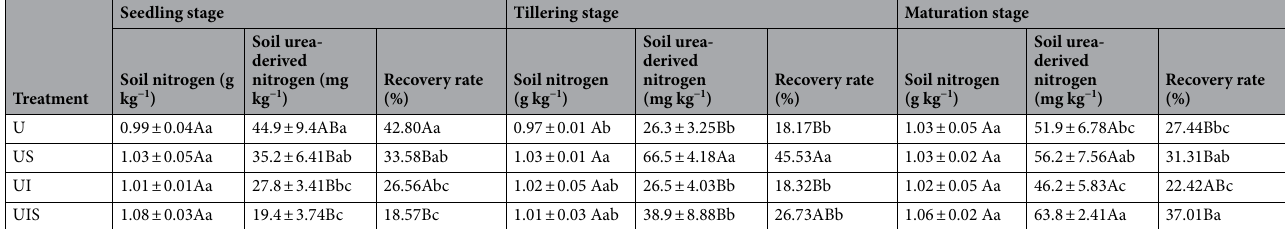
Table 1. Soil total nitrogen, soil urea-derived nitrogen and the recovery of urea-N in soils at three sampling stages. U: 15 N labeled urea; US: 15 N labeled urea + straw; UI: 15 N labeled urea + inhibitor; UIS: 15 N labeled urea + inhibitor + straw. The values in the table represent the mean of three replicates. Different capital letters represent significant differences of the same treatment at different sampling times; different lowercase letters represent significant differences among treatments during the same sampling period (Duncan, P <